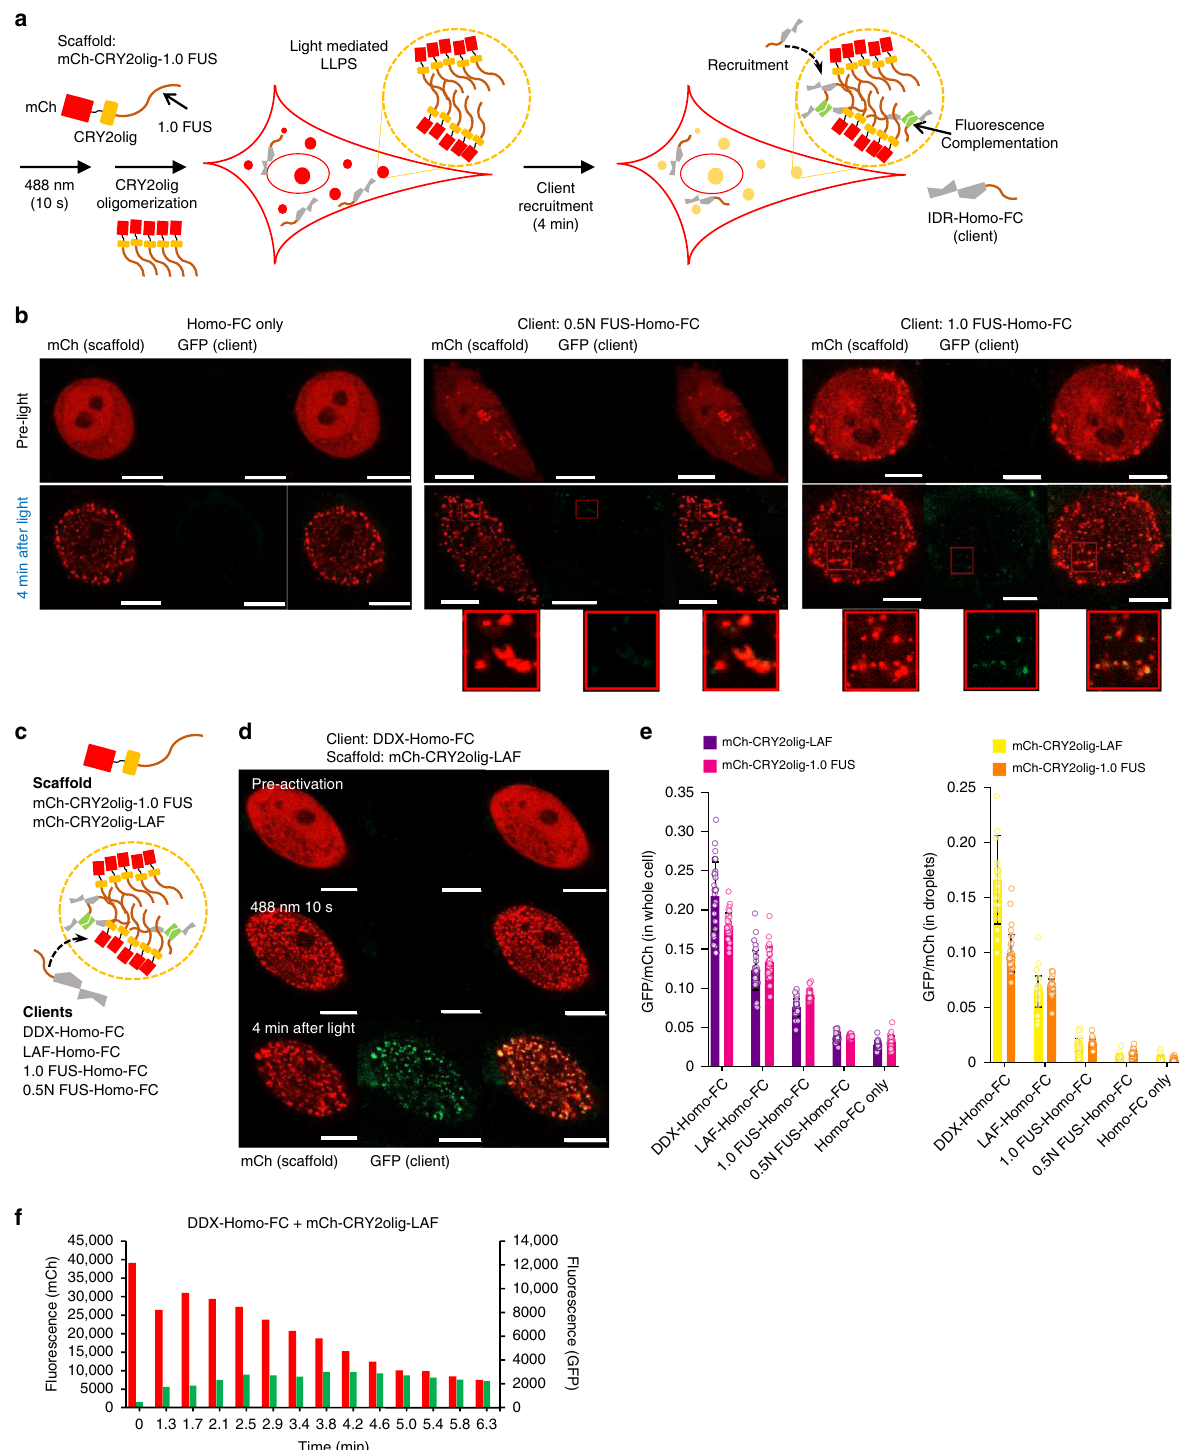
Fig. 4 Real-time observation of fl uorescence complementation inside light-induced IDR compartments. a Schematic illustration of light-induced cellular condensate formation of mCh-CRY2olig-1.0 FUS, 0.5 N FUS – Homo-FC recruitment, and subsequent client complementation for (green) fl uorescence turn- on. b Fluorescence images of cells expressing mCh-CRY2olig-1.0 FUS (scaffold) with client Homo-FC only (left), 0.5 N FUS – Homo-FC (middle), and 1.0 FUS – Homo-FC (right) before and after 10 s 488 nm light activation and 4 min incubation. c Schematic illustration of light-inducible cellular condensates with two kinds of scaffolds and four different Homo-FC clients with various IDPs. d Fluorescence images of cells expressing mCh-CRY2olig-LAF (scaffold) with client DDX-Homo-FC before and after 10 s 488 nm light activation, followed by 4 min incubation. e Total GFP(complemented Homo-FC)-to-mCh ratios for whole cells (left) or condensates (right) with various combinations of IDP scaffolds and clients. Data are presented as mean values with ±1 SD as error bars ( n = 33 cells from three independent experiments). f Scaffold (mCh) and client complementation (GFP) signal changes inside condensates at various time points after 10 s light activation. Scale bars: 10 μ